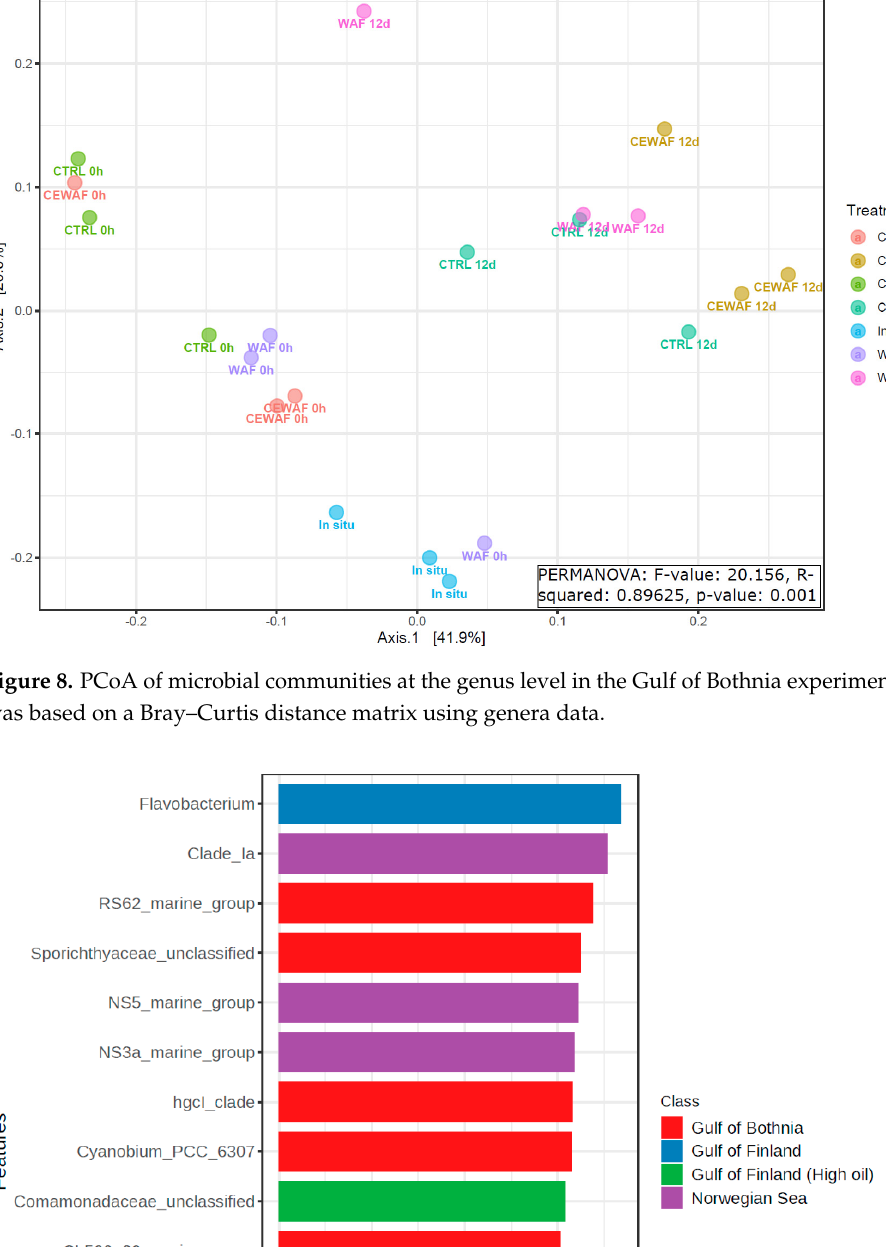
Figure 7. PCoA of microbial communities in the Norwegian Sea experiment. PCoA was based on a Bray–Curtis distance matrix using genera data.